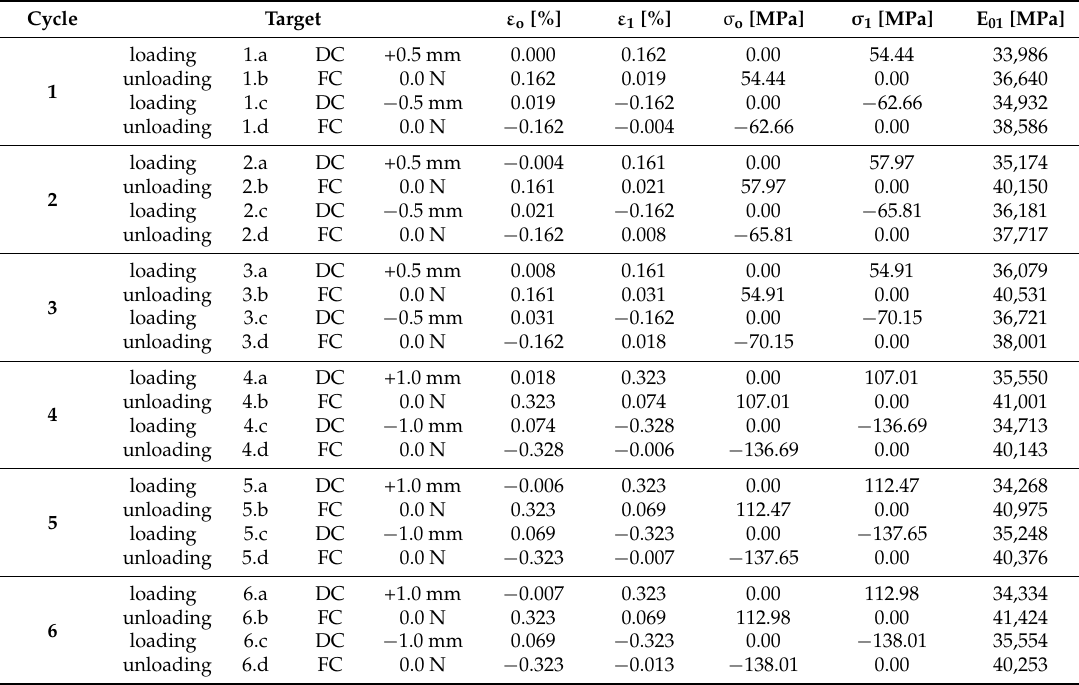
Figure 11. Multistep experimental procedure for preliminary tests (GFRP sample “2”). Table 6. Preliminary tests (GFRP sample